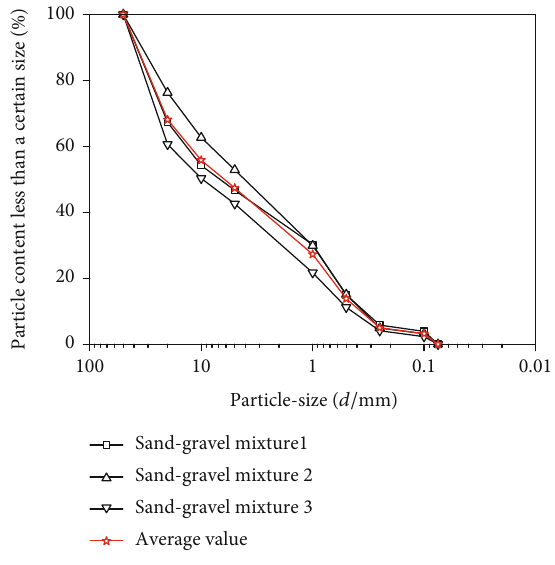
Figure 1: Gradation curve of sandy gravel.